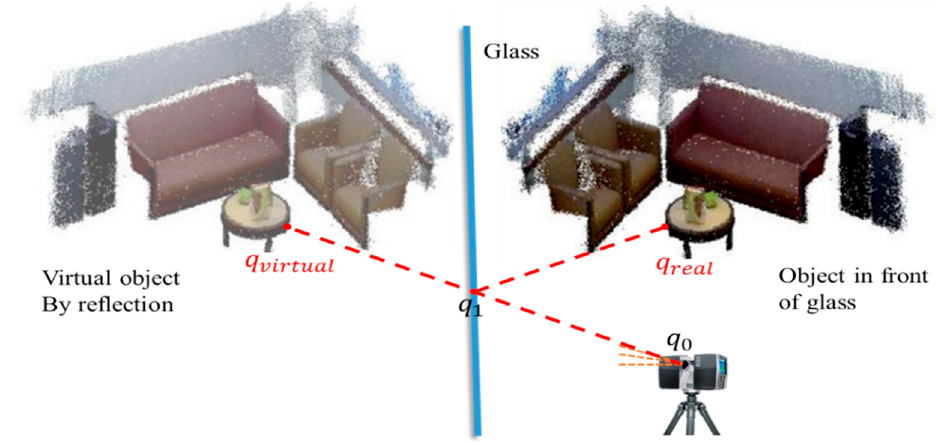
Figure 1. Principle of reflection in a LiDAR laser scanner.